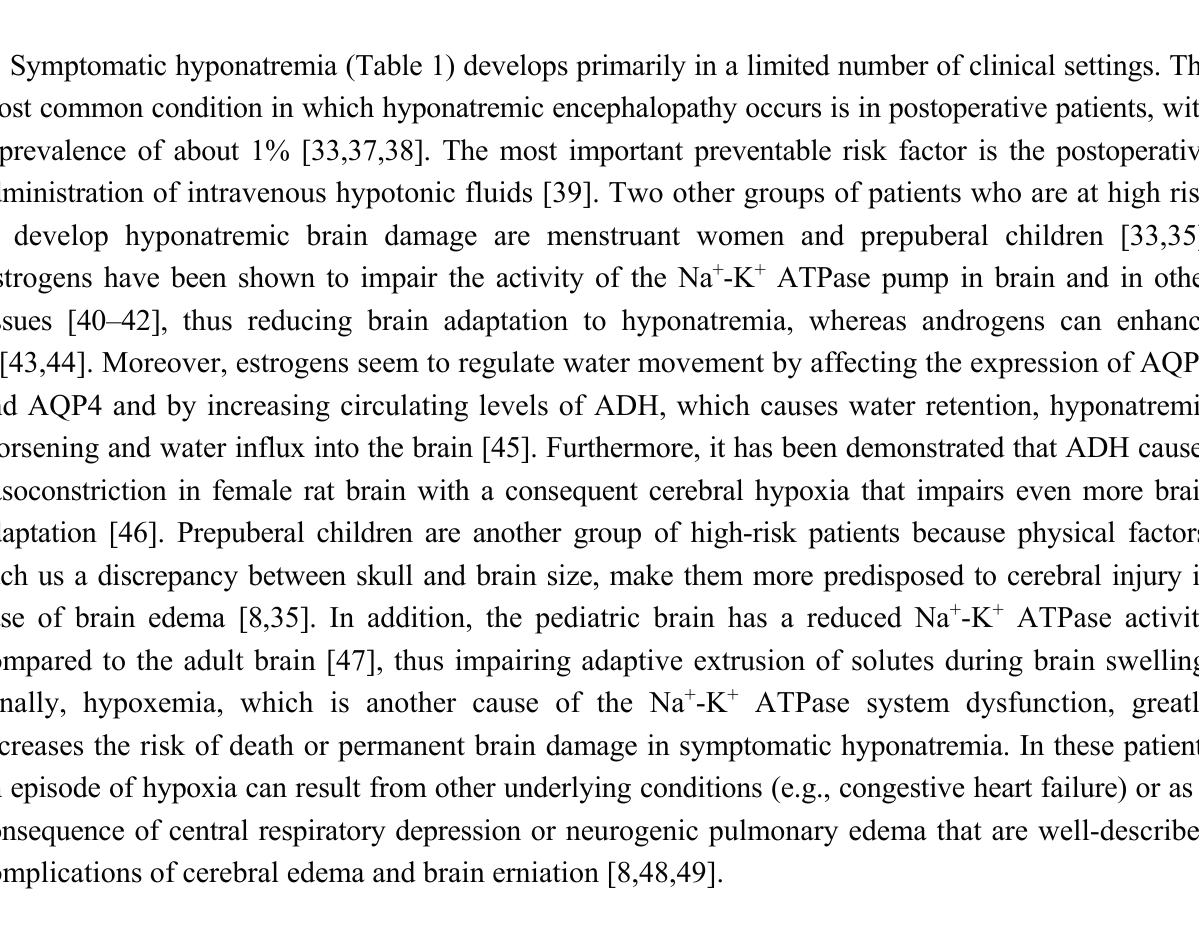
Table 1. Clinical features of hyponatremic